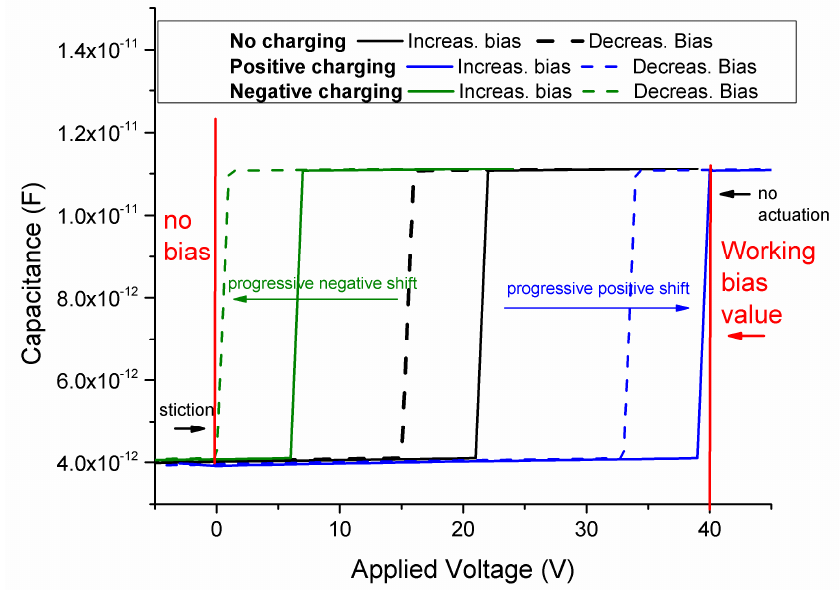
Figure 2. Scheme of capacitance–voltage (C–V) curves of a capacitive MEMS switch with charging phenomena. When the bias is applied, the actuation and release voltages can drift to higher values (positive charging) or lower values (negative charging).